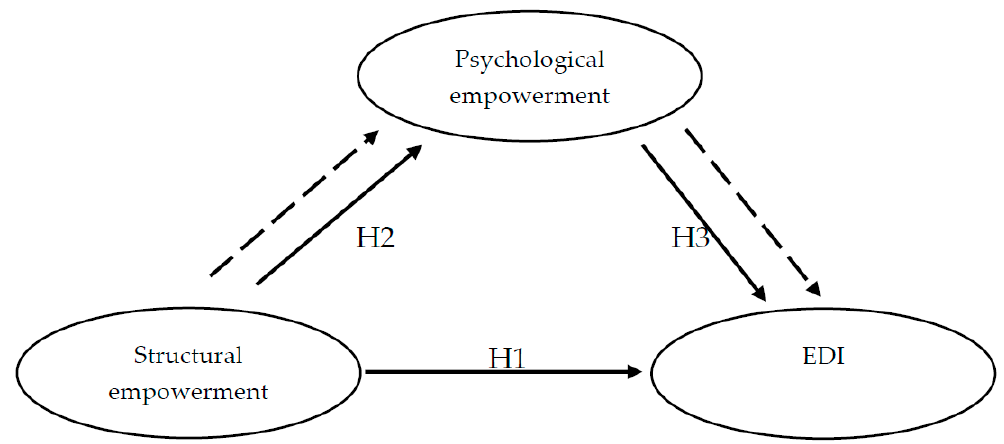
Figure 1. Hypothesized model. Notes: Direct parts are represented with straight arrows. The mediation part is represented with the dashed